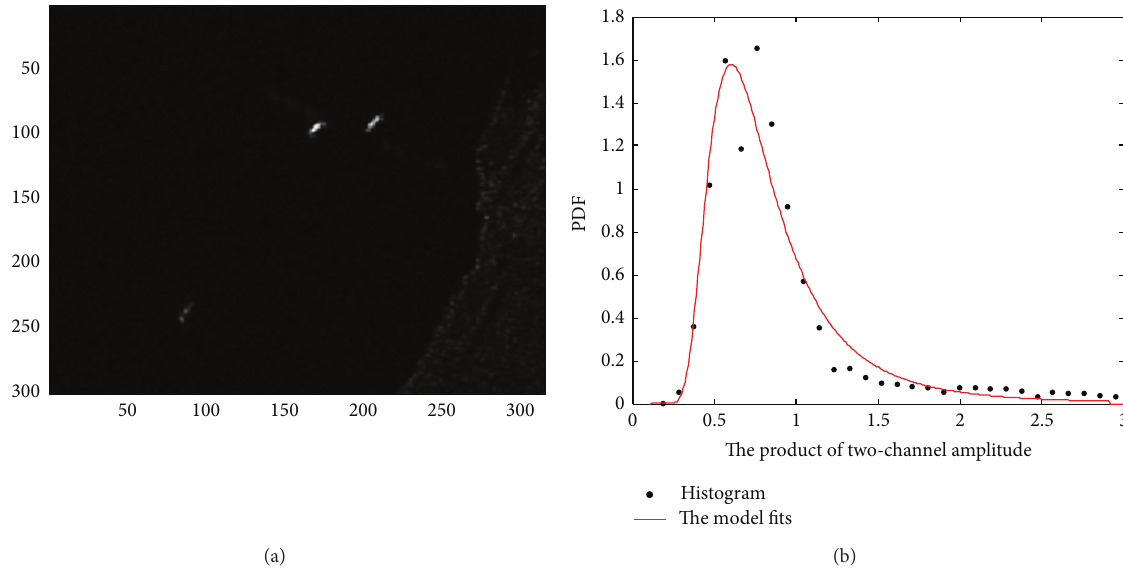
Figure 2: The ship chip: (a) the product image; (b) the fitting